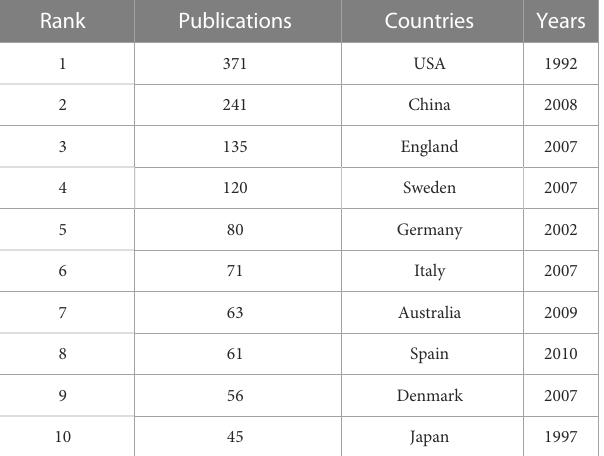
TABLE 1 Top 10 countries in number of publications related to T2DM and DNA/RNA methylation modi fi cations. Rank